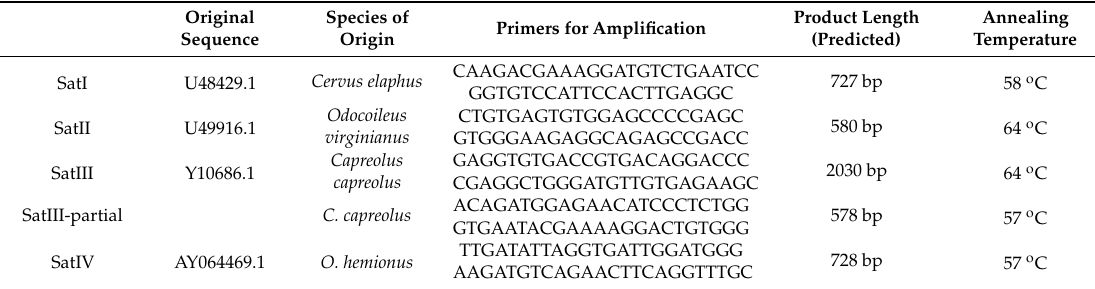
Table 1. Original sequences, primers, predicted amplicon sizes, and annealing